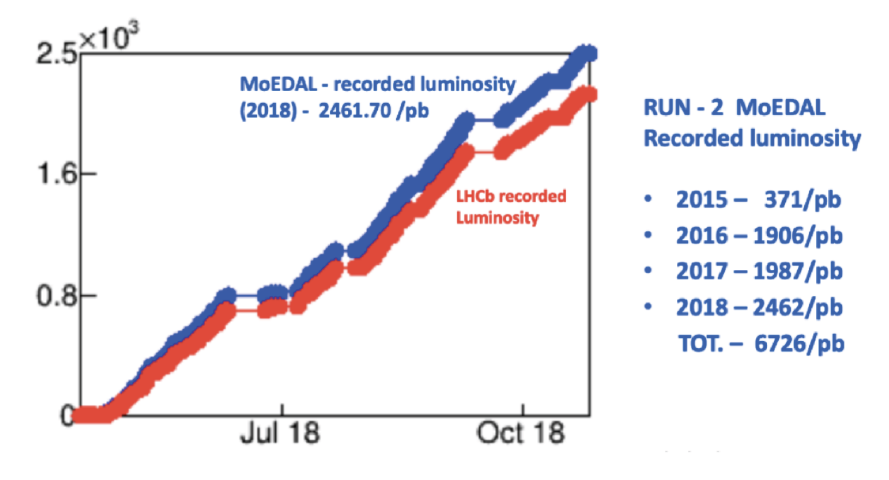
Figure 7. A plot of the luminosity delivered to MoEDAL and LHCb at